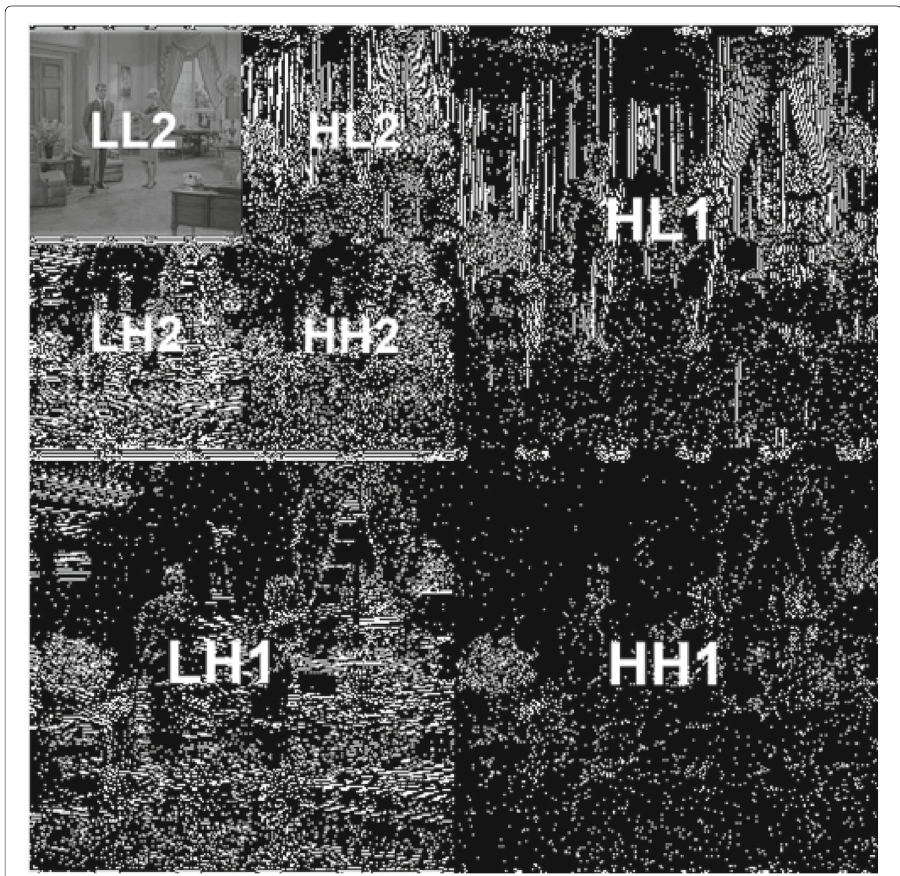
Fig. 3 Two-stage wavelet decomposed image exhibiting directional correlations in different subbands